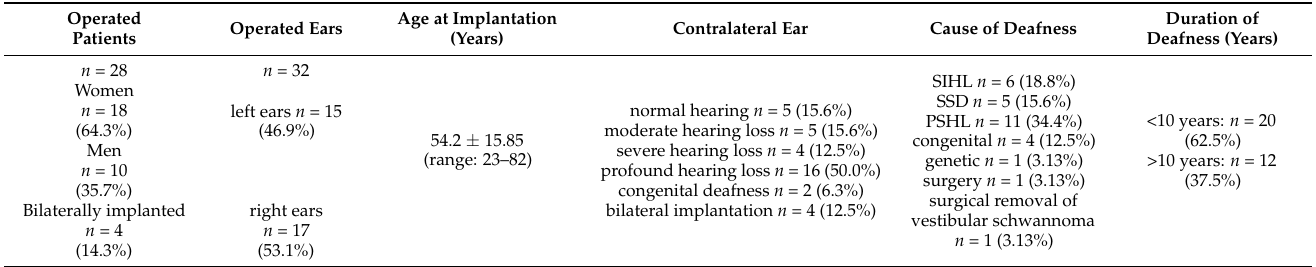
Table 1. Summary of the epidemiological